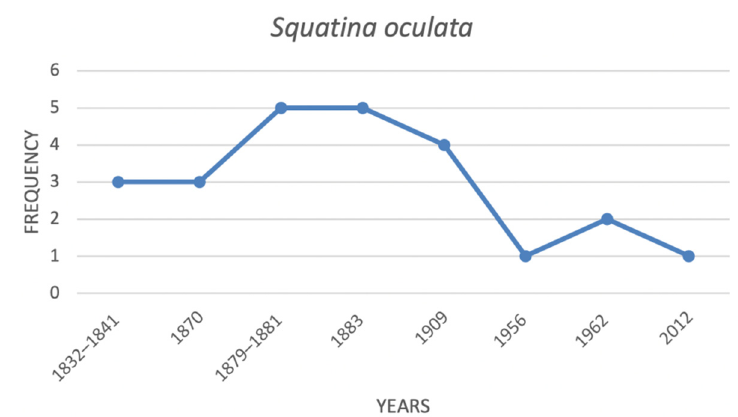
Figure 4. Temporal trend of Squatina oculata .